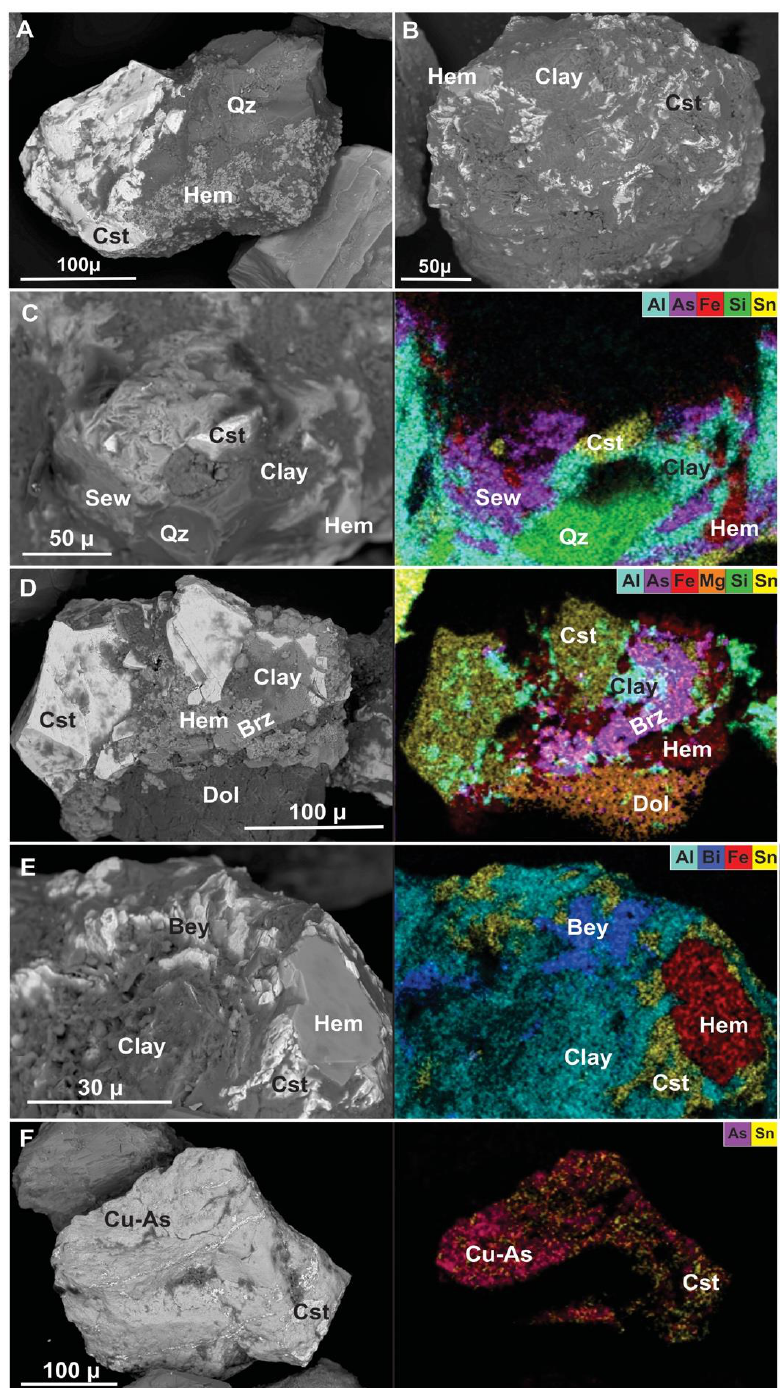
Figure 10. Cassiterite-bearing composite grains. ( A ) Cst-Hem-Qz; ( B ) Cst-Hem-Clay; ( C ) Cst-Hem- Qz-Sew-Clay; ( D ) Cst-Hem-Dol-Brz-Clay; ( E ) Cst-Hem-Bey-Clay; ( F ) Cst-(Cu-Ca Arsenate). Sew: Sewardite; Cst: Cassiterite; Qz: Quartz Brz: Berzeliite; Dol: Dolomite; Bey: Beyerite.